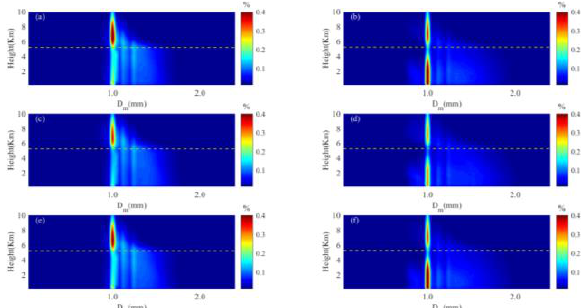
Figure 5. The Contoured frequency by altitude diagrams for droplet radius average of stratiform and convective precipitation at each stage. The stages of developing, mature, and dissipating stage was indicated respectively from the rows 1 to 3. The left (right) column indicates the style of stratiform cloud precipitation (convective cloud precipitation).